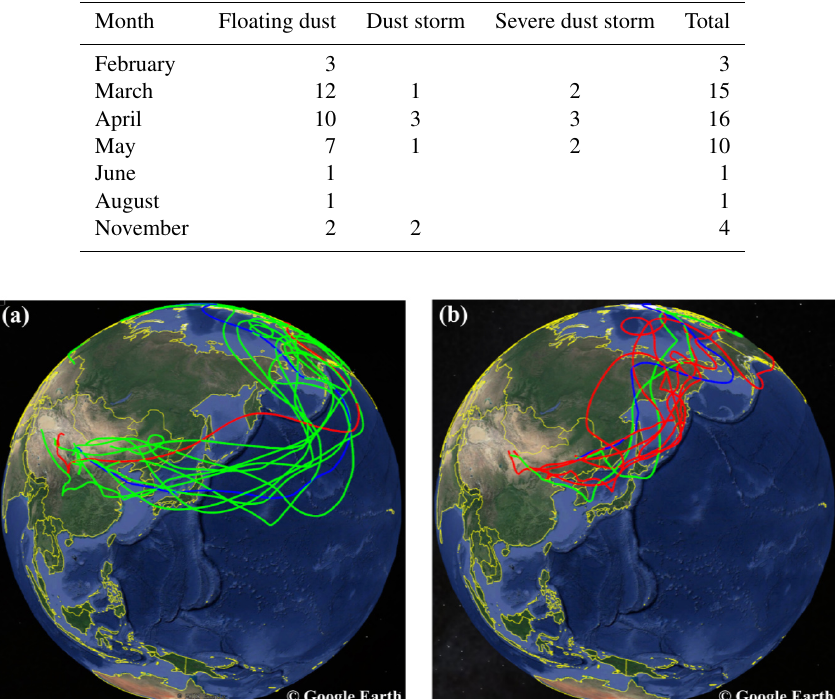
Figure 2. Two common transport pathways of dust originating from China to the Arctic, i.e., (a) the northern China–Korean Peninsula/Japan– North Pacific Ocean–Arctic pathway and (b) the northern China–Korean Peninsula/Japan–Kamchatka Peninsula–East Siberia–Arctic path- way. Red, blue, and green curves represent forward trajectories starting at altitudes of 500, 1000, and 1500m, respectively. © Google Earth